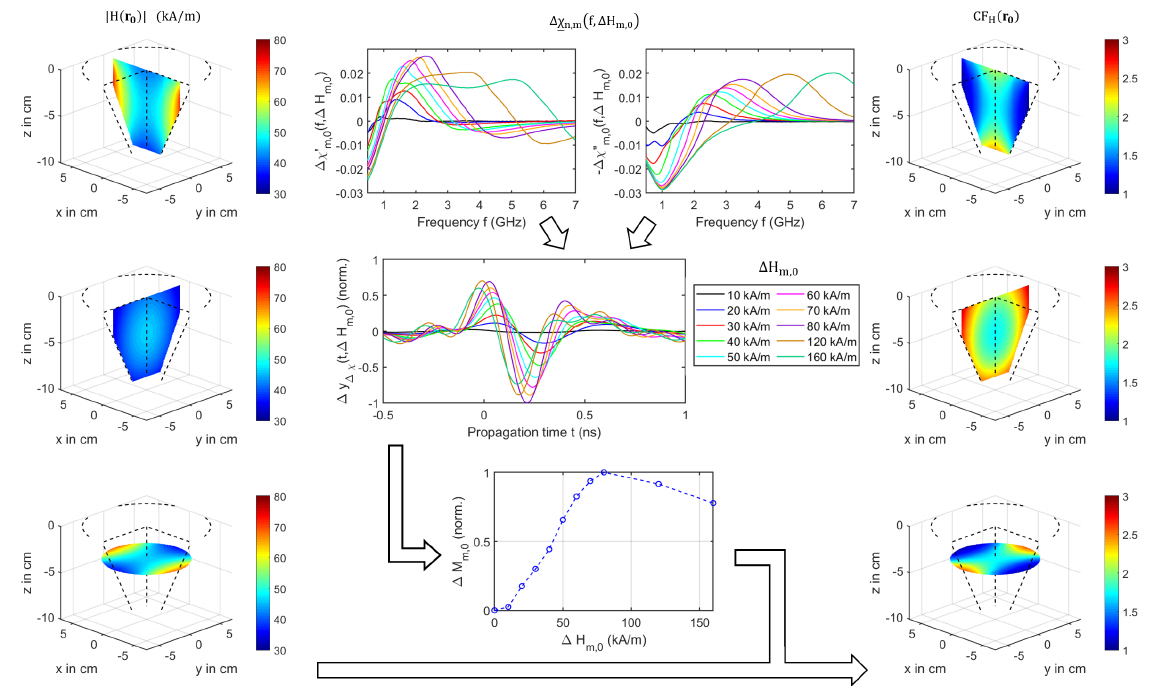
Figure 11. Compensation of the magnetic field inhomogeneity. The absolute value of the measured magnetic field intensity ) | (left column). Differential magnetic susceptibility ∆ χ | H ( r 0 field intensities (according to [40]), the estimated differential signal ∆ y ∆ χ ( t , ∆ H m ,0 ) , and the derived normalization curve as a function of ∆ H m ,0 with B f = 1–4GHz scaled to its maximum at H m ,0 = 80 kA/m (middle column). The 3D correction matrix CF H ( r 0 ) computed by Equation (31) (right